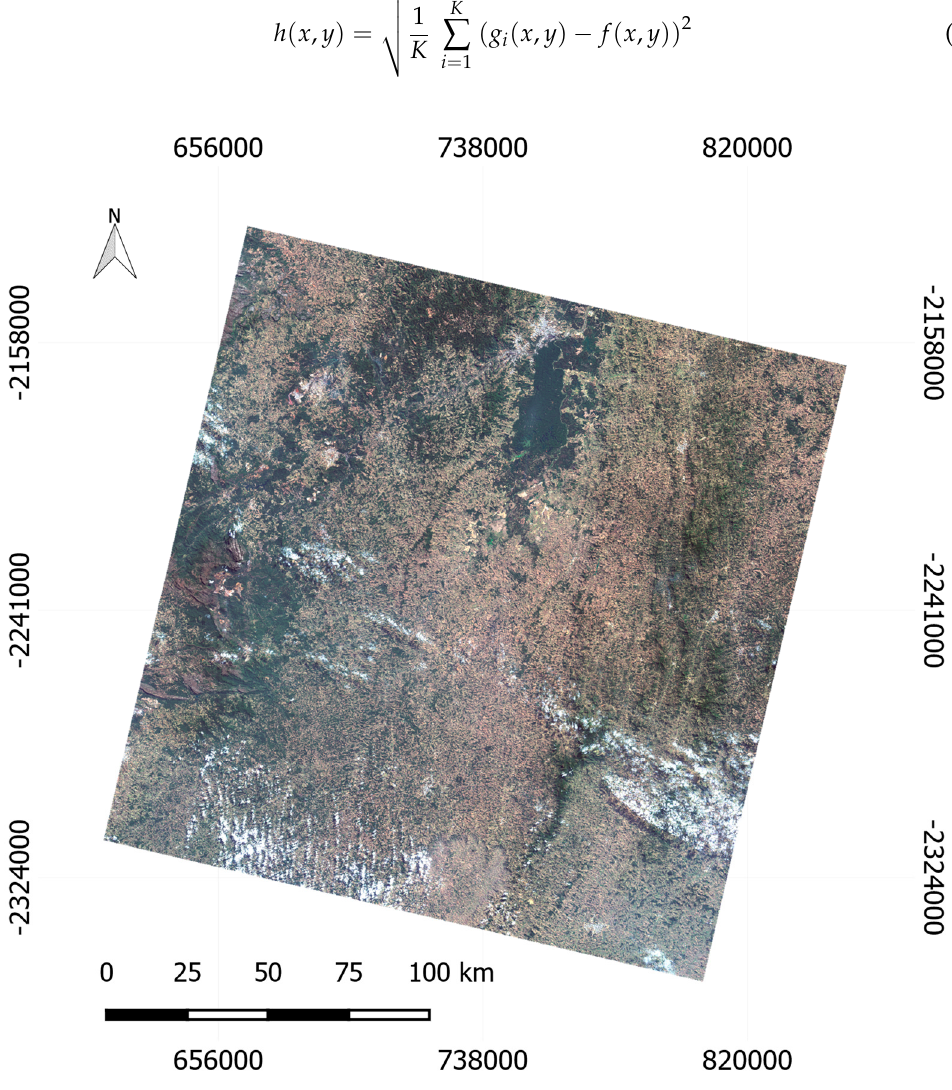
Figure 4. Example of an enhanced Landsat 8 scene of the Doce River basin in Brazil. The Doce River and its tributaries are not visible because this image was not zoomed.